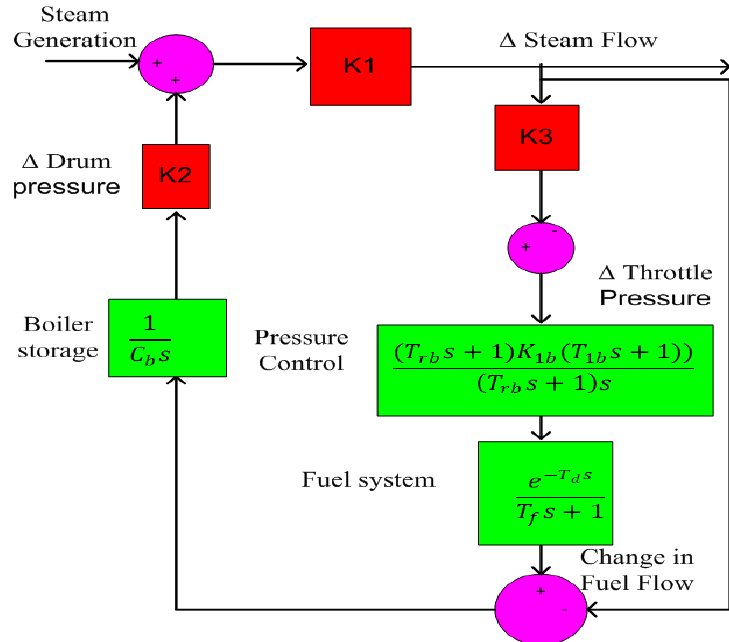
Figure 2. Schematic model of boiler dynamic.